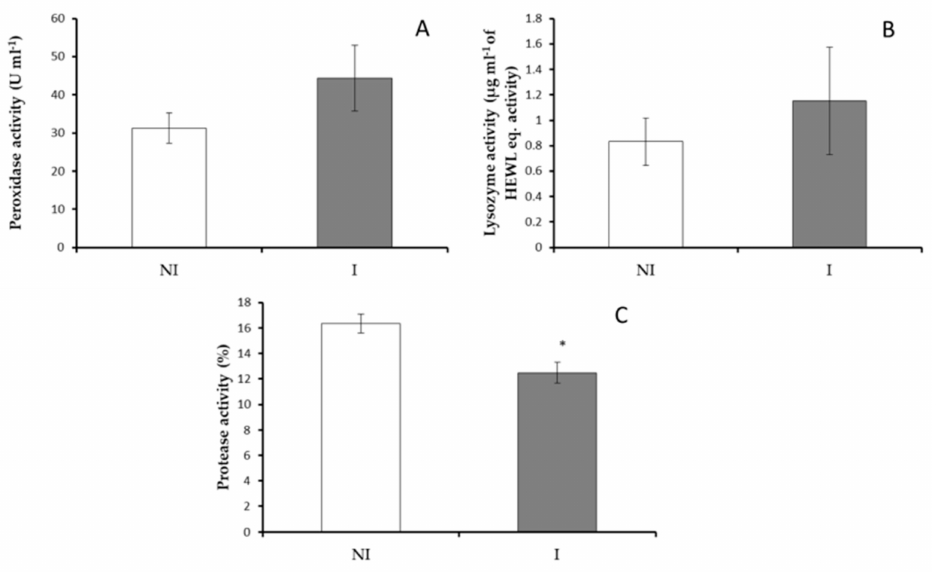
Figure 3. Skin mucus immune response in non-infected (NI) and infected (I) European sea bass. ( A ) peroxidase, ( B ) lysozyme, ( C ) protease activities. Data are represented as means ± SEM (n = 9). Asterisks denote significant differences between groups ( p <